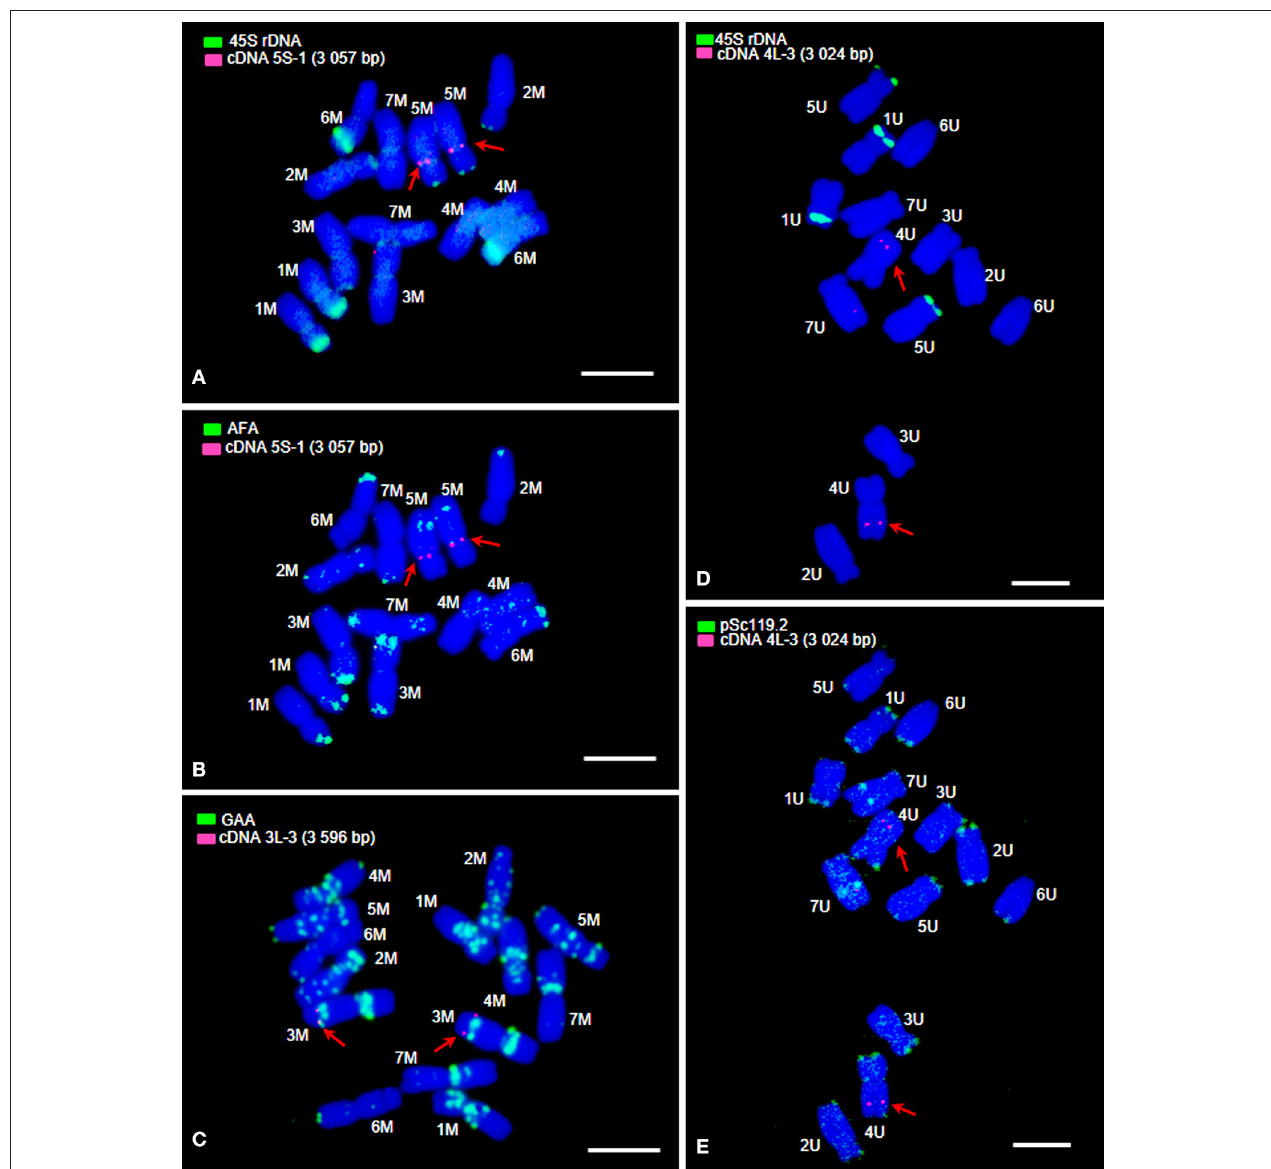
FIGURE 1 | Fluorescence in situ hybridization (FISH) with probes for 45S rDNA, Afa family repeat, GAA microsatellites, pSc 119.2 repeat, and cDNAs (red arrows) on mitotic metaphase chromosomes of Ae. umbellulata and Ae. comosa . FISH on chromosomes of Ae. comosa (A) 45S rDNA (green) and cDNA (red); (B) Afa family repeat (green) and cDNA (red); (C) GAA microsatellites (green) and cDNA (red). FISH on chromosomes of Ae. umbellulata (D) 45S rDNA (green) and cDNA (red); and (E) pSc 119.2 repeat (green) and cDNA (red). The chromosomes were counterstained with DAPI (blue). Bars = 5 µ